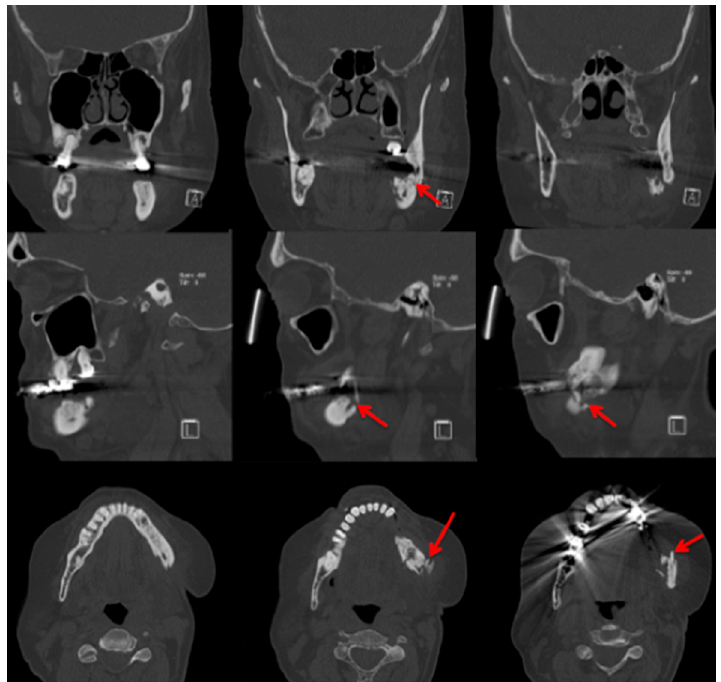
Figure 5. Computed tomography (Siemens, Sensation 64) Patient: 66 years old, male, secondary osteoporosis due to castration, alendronate. Red arrow points in the direction of the fracture due to the bisphosphonate necrosis. The panoramic radiograph is shown in Figure 3 and the 99Tcm-DPD SPECT and 99Tcm-DPD SPECT/CT in Figures 8 and 9 respectively. AAMOS staging: stage 3.